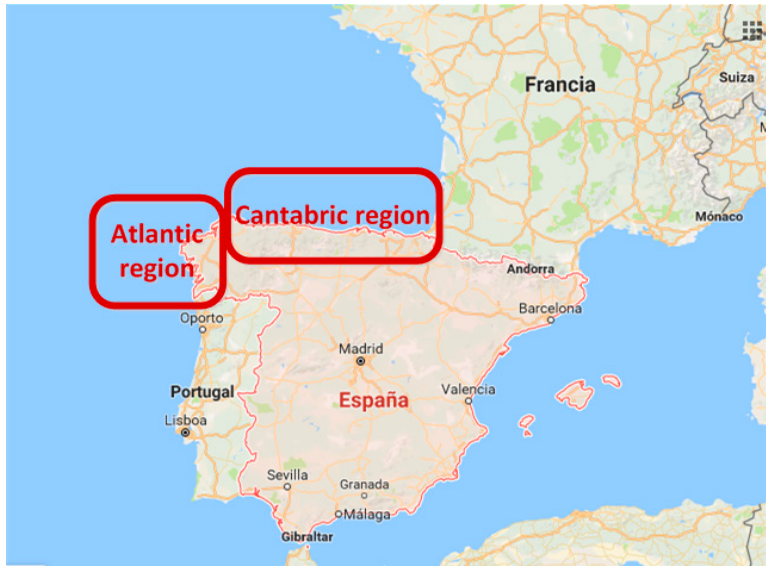
Figure 2. Spanish regions selected.